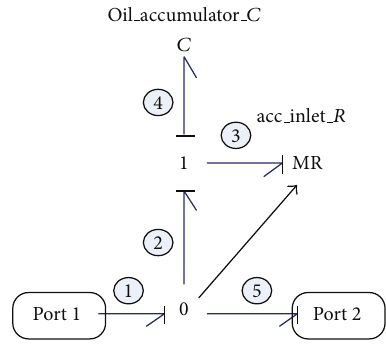
Figure 8: Bond graph model of the accumulator.